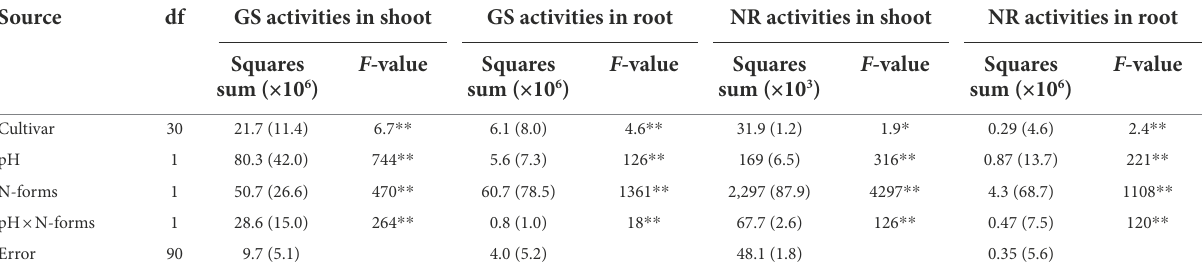
TABLE 3 F- values in two-way ANOVA analysis of GS and NR activities in shoot or root of 31 wheat cultivar seedlings under different N-sources and pH